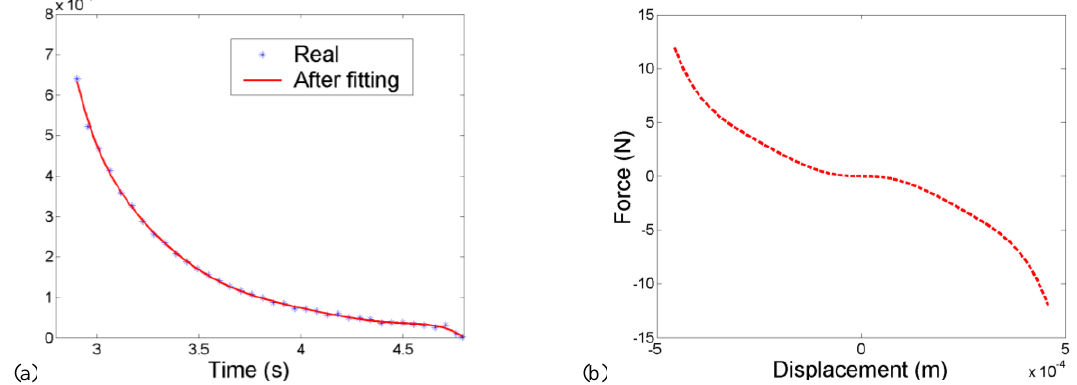
Fig. 7. Peaks of the displacement (a) and nonlinear force estimated (b), release test.